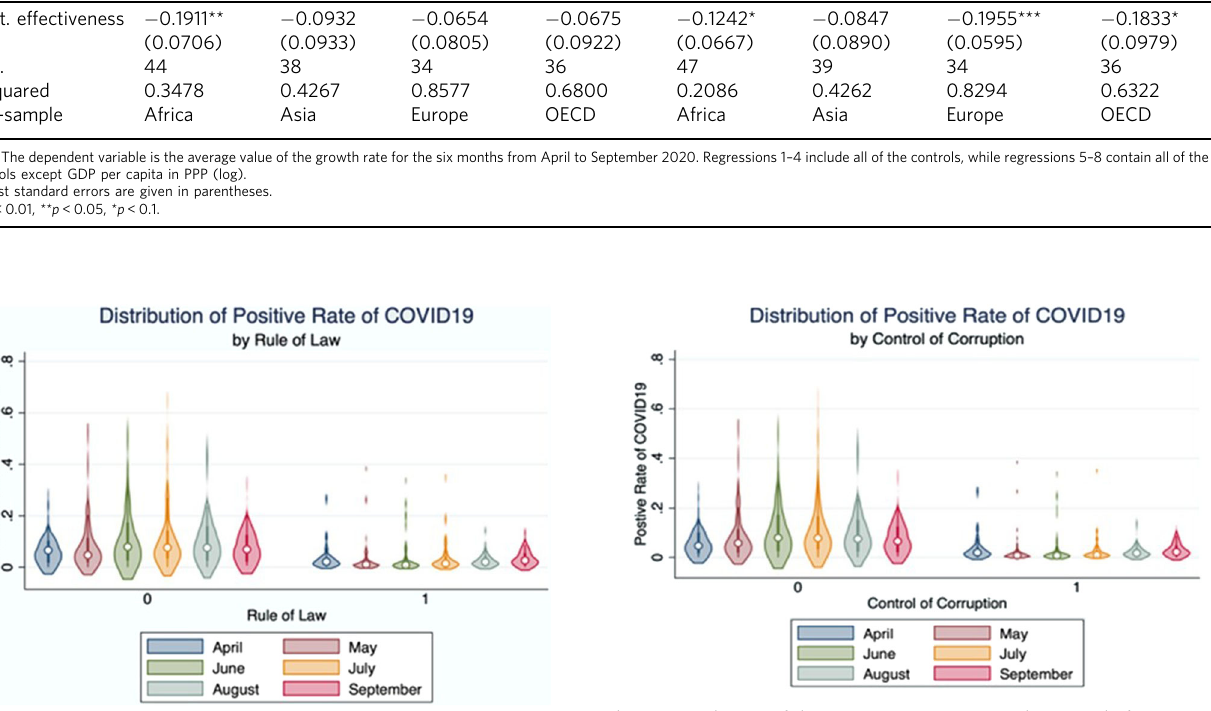
Fig. 10 Distribution of the COVID-19 positive rate by control of corruption.